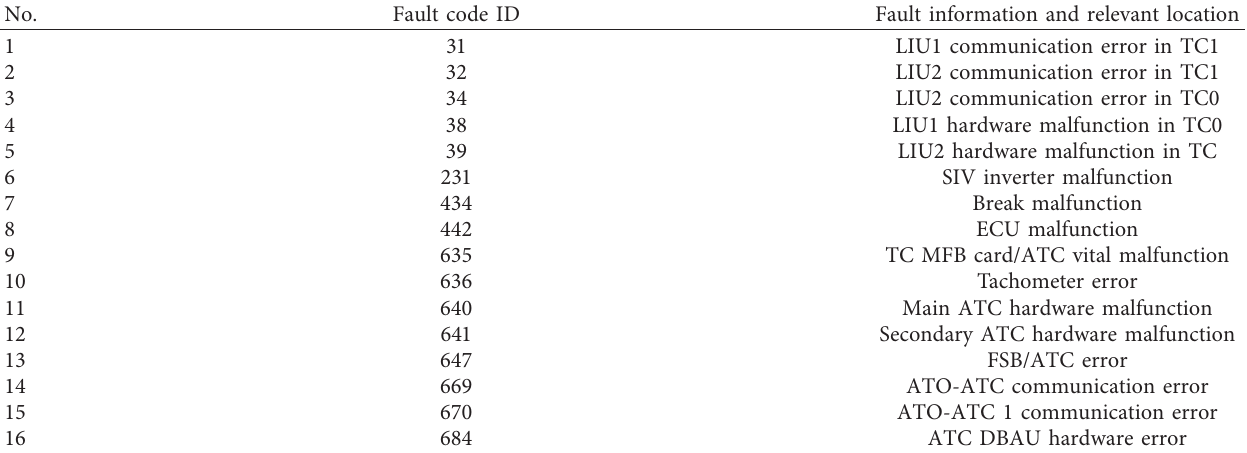
Table 6: Fault types and their information for RUL predictions.